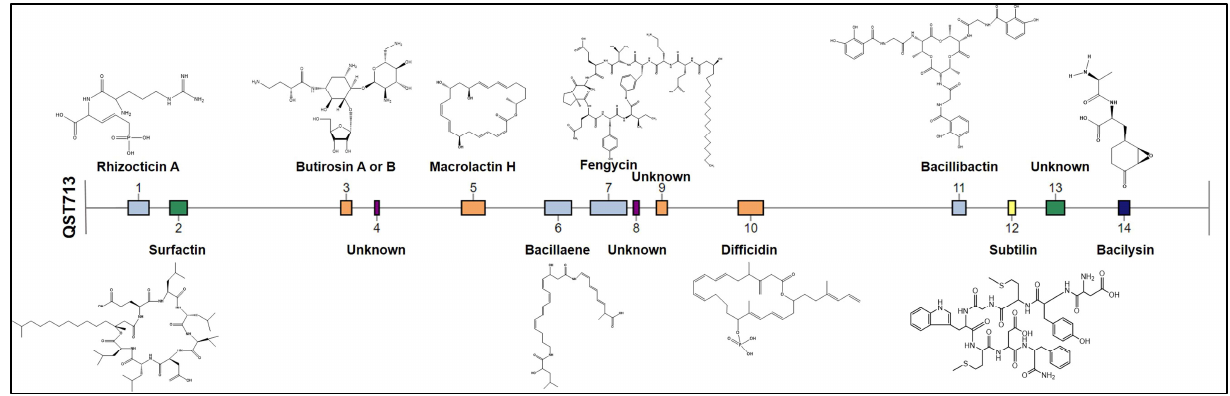
2.1. Antimicrobial Substances Synthesized by B. velezensis to Control Plant Pathogens B . velezensis is an endospore-forming and free-living soil bacterium first described by Ruiz-Garcia in 2005, and was previously classified as another Bacillus species before being reconfirmed as B . velezensis [18]. B . velezensis produces various secondary metabolites that act against different phytopathogenic microbes. For example, whole-genome analysis revealed that B . velezensis HNA3 had 12 gene clusters responsible for the synthesis of 14 secondary metabolites. Among the metabolites, five nonribosomal LPs are fengycin, bacillomycin D, surfactin, mycosubtilin, and bacillibactin; three PKs are macrolactin, dif- ficidin, and bacillaene; two antimicrobial peptides are bacilysin and amylocyclicin; and other secondary metabolites include plipastatin, iturin, paenibactin, and paenilarvins [17]. Another genome analysis of B . velezensis QST713 (previously reported as B . subtilis QST713) revealed that at least 12% of the genome of this bacterium is involved in the biosynthesis, regulation, and transport of LP and PK molecules (Figure 1). In addition to the antimicrobial compounds found in B . velezensis FZB42 or B . velezensis SQR9, this bacterium contains two additional gene clusters that encode rhizocticin- and subtilin-like compounds (ericin) [19].